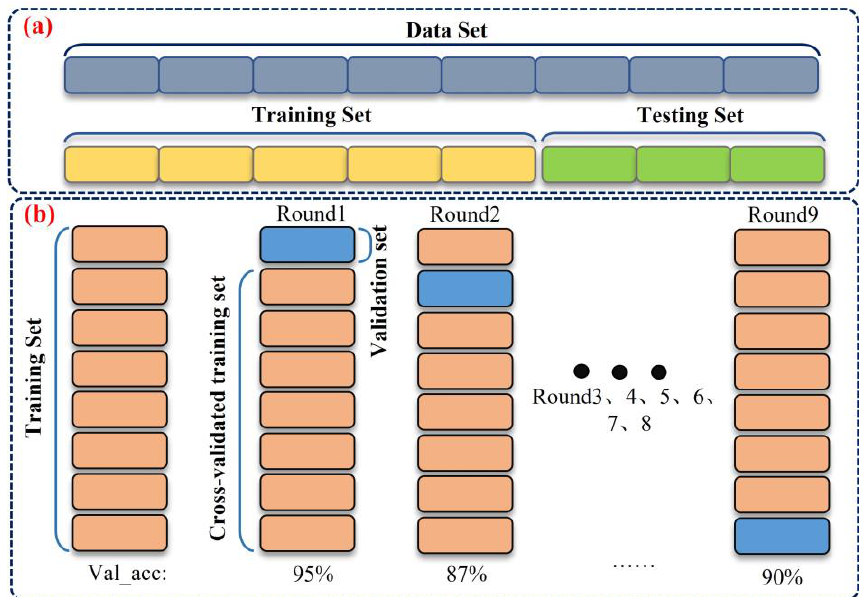
Figure 4. Data set partitioning and grid search: ( a ) dividing the data set into a training set and a test set; ( b ) grid search and cross-validation Schematic.